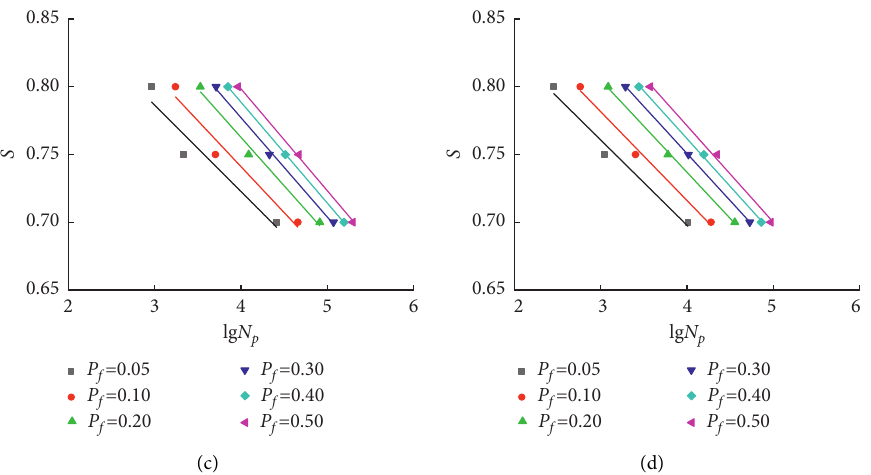
Figure 10: S –lgN relationships of AASC with various degrees of frost damage for various failure probabilities. (a) n � 0. (b) n � 50. (c) p n � 100. (d) n � 150.